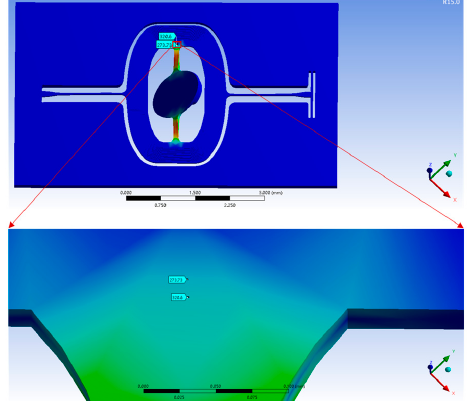
Figure 4. The relation between output voltage and doping concentration.